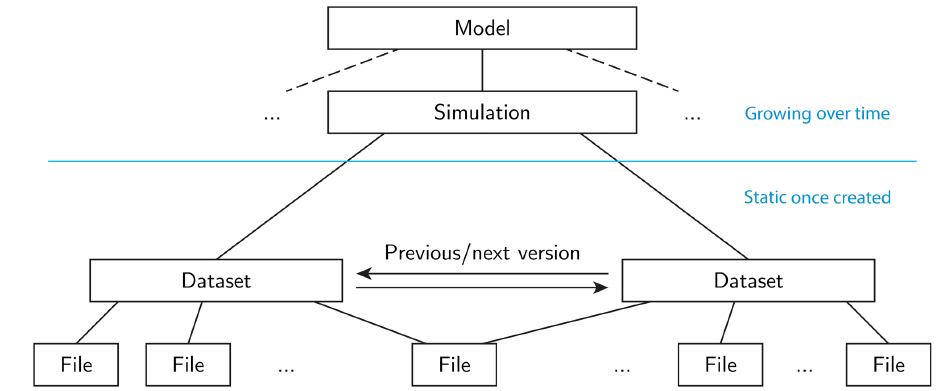
Figure 3. Schematic PID architecture, showing layers in the PID hierarchy. In the lower layers of the hierarchy, PIDs are static once generated, and new datasets generate new versions with new PIDs. Each file carries a PID and each collection (dataset, simulation, and so on) is related to a PID. Resolving the PID in the Handle server guides the user to the file or the landing page describing the collection. Each box in the figure will be uniquely addressed by its PID.